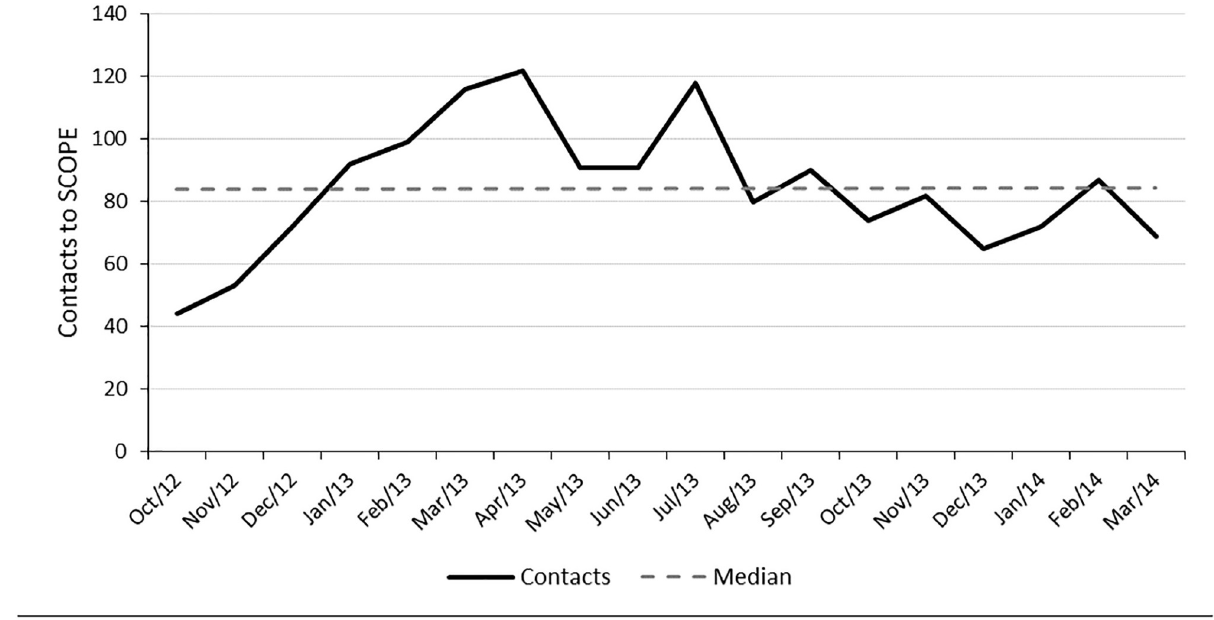
Fig 1. Total monthly calls to the SCOPE